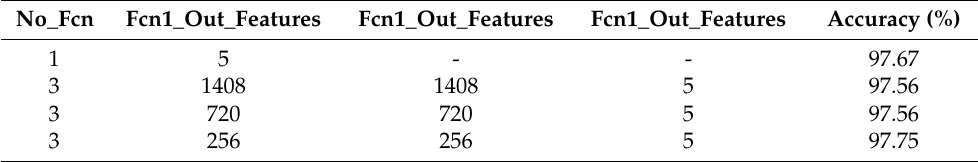
Table 4. EfficientNetB2Different feature vectors performance.